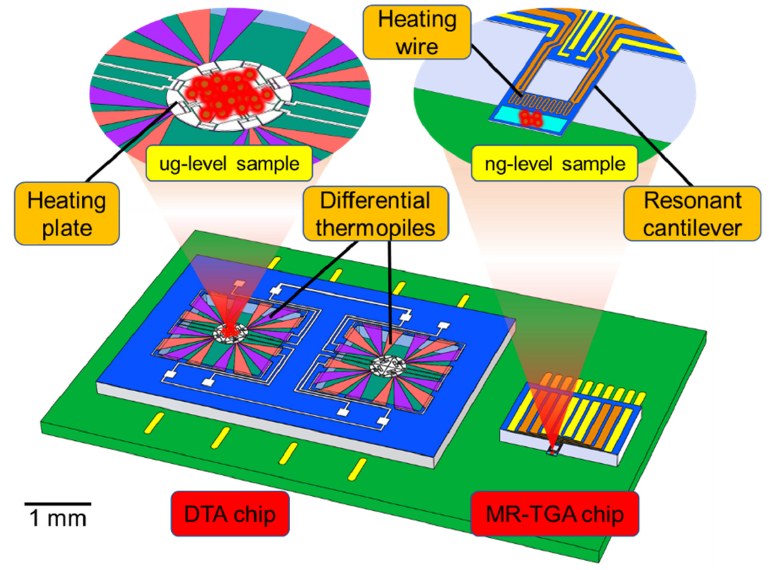
Micromachines 2022 , 13 , x FOR PEER REVIEW Figure 1. 3D schematic of the proposed TG/DTA microsystem. Figure 1. 3D schematic of the proposed TG/DTA microsystem.